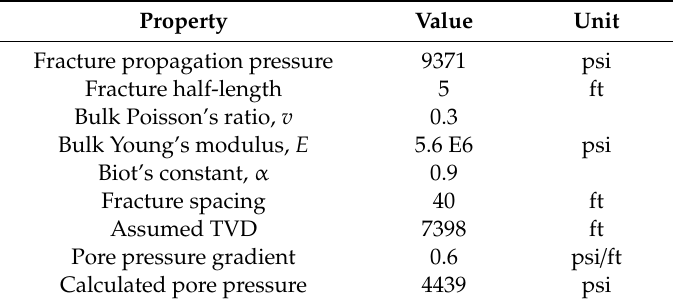
Table 1. LSM model for two hydraulic fractures.